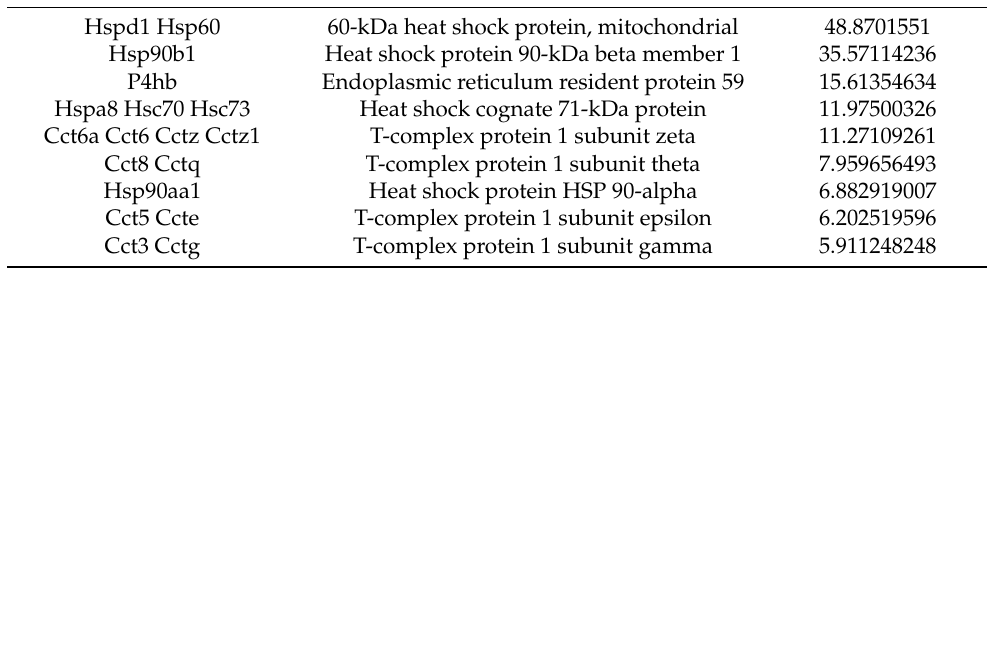
Table 1. Structural changes of protein folding-related genes after macrophage activation for 24 h.